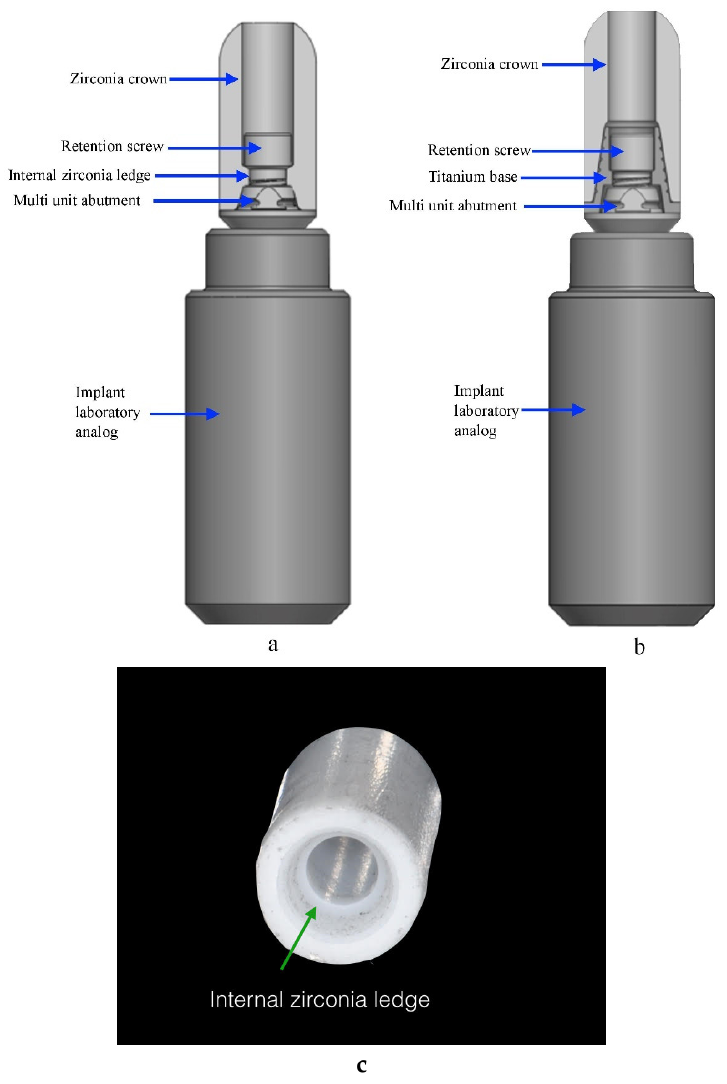
Figure 5. Components of the zirconia-abutment restorations. ( a ) Screwed restoration; ( b ) screwed-cemented restoration; ( c ) apical view of the screwed zirconia cap. Note the internal zirconia ledge for the support of the screw head.